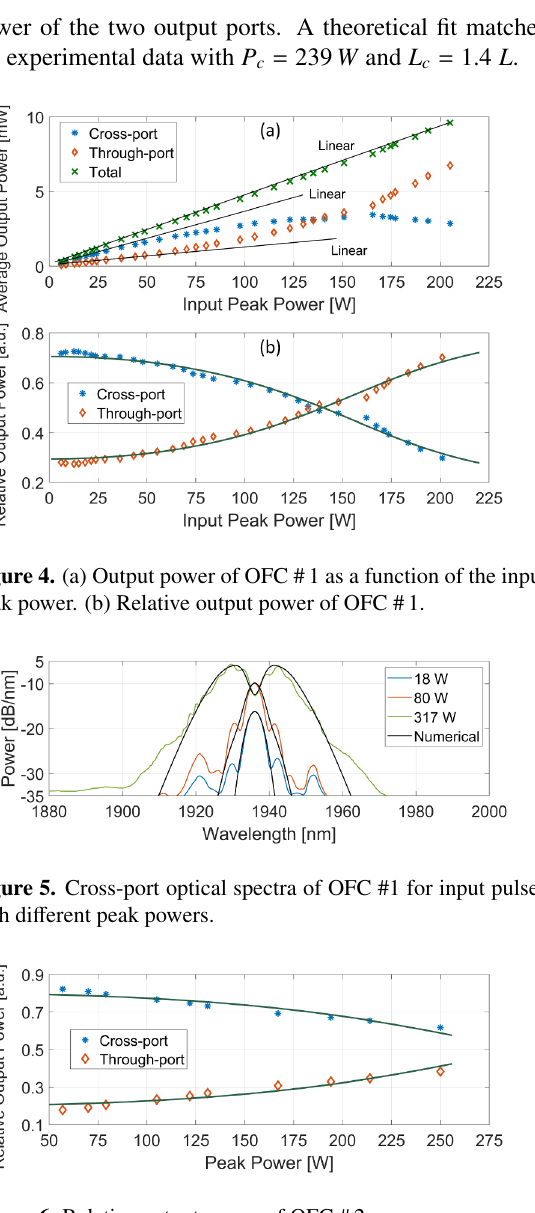
Figure 6. Relative output power of OFC